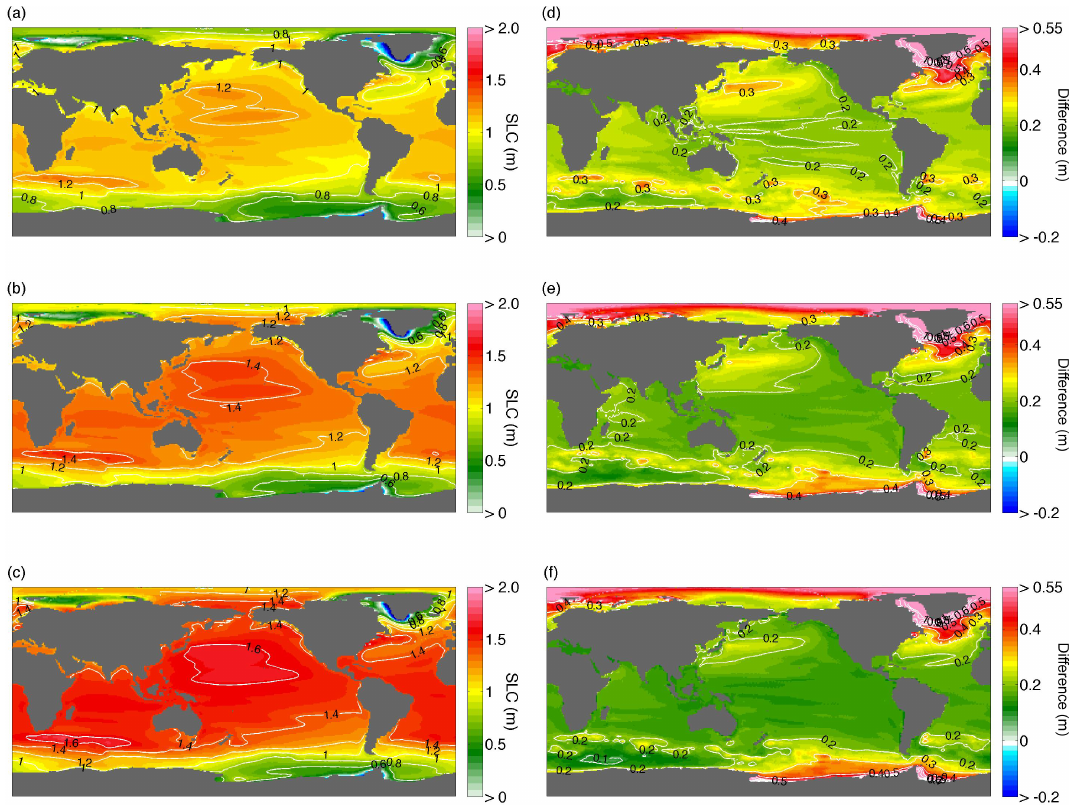
Figure A3. Sea level change (SLC) projections for high-end percentiles and the change therein by 2090 if asymmetric VW15 dynamical ice sheet mass loss is partly correlated with climate-change-induced SLC changes. Left column: (a) 90th, (b) 95th and (c) 97.5th percentile for the asymmetric VW15 distribution of dynamical ice sheet mass loss combined with regional SLC projections following RCP8.5 (Slangen et al., 2014). It is assumed that the dynamical ice sheet mass loss of Greenland ice sheet is fully correlated with all other regional changes in SLC. Dynamical ice sheet mass loss of West Antarctic ice sheet is assumed to be 70% when correlated with this combined probability distribution. The dynamical ice mass loss contribution of East Antarctic ice sheet is assumed to be fully uncorrelated with the other components. Right column: difference between the uncorrelated and partly correlated simulations (both combined with regional SLC projections following RCP8.5 (Slangen et al., 2014) and VW15 distributions) for the (d) 90th, (e) 95th and (f) 97.5th